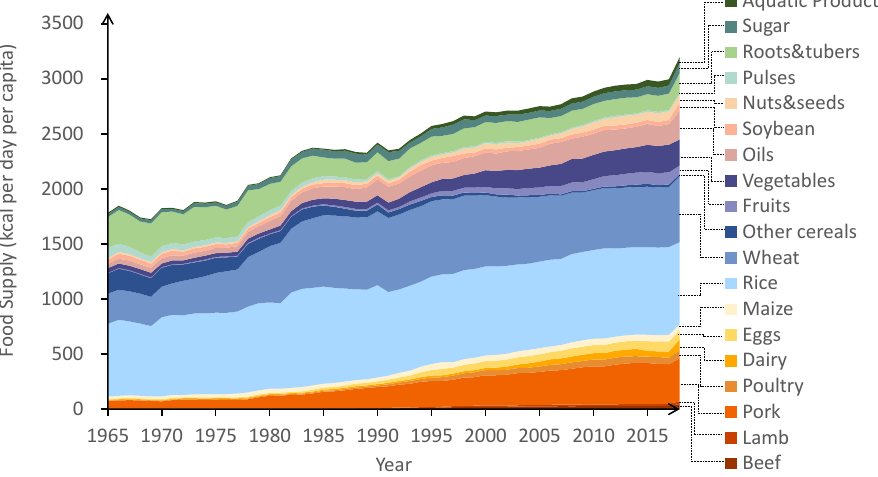
Figure 1. The supply of different food categories of Chinese residents from 1965 to 2018 .